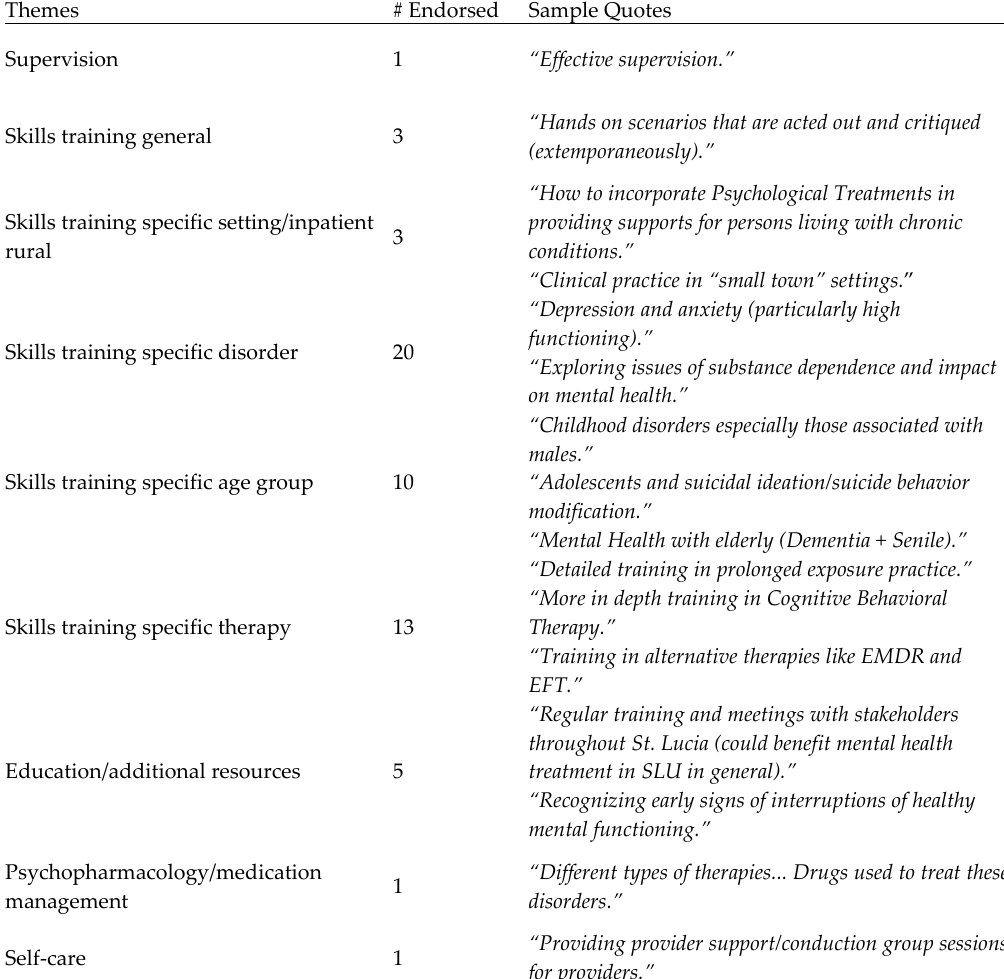
Figure 3. Major themes derived from analysis of qualitative workshop feedback. Note: Minor typos and spelling errors were corrected.